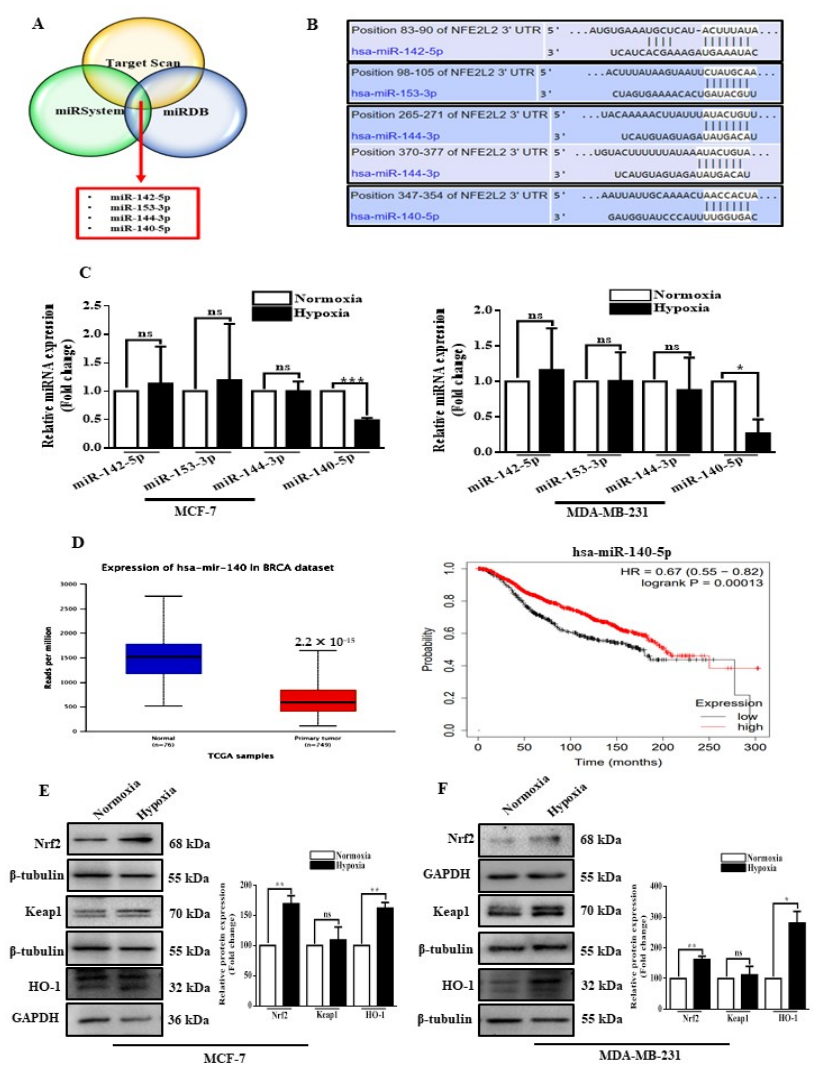
Figure 1. miR-140-5p and Nrf2 expression in BC cells under hypoxia. ( A ) Venn diagram showing common miRNAs computationally predicted to target Nrf2 mRNA by all three algorithms (Target Scan, miRDB, and miRSystem). ( B ) Schematic of the predicted binding site of all four miRNAs in the 3 (cid:48) -UTR of Nrf2 mRNA. ( C ) qRT-PCR analysis of all four selected miRNAs in MCF-7 and